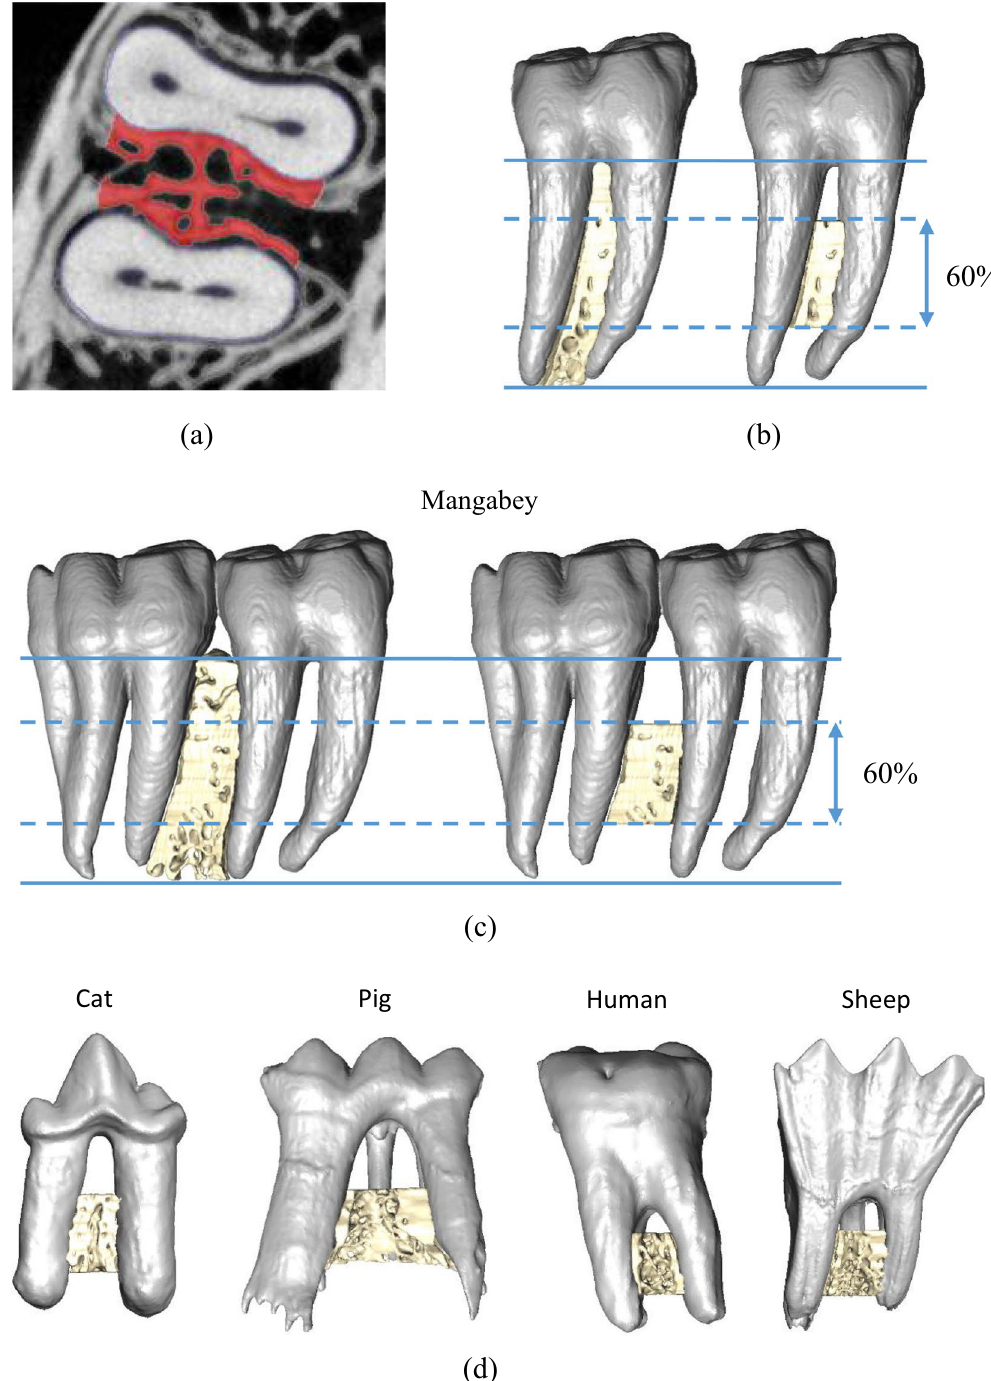
Figure 5. Segmentation of RTT and RST VOIs, showing: ( a ) mapping of the largest area of bone between the medio-lateral borders of the tooth root; ( b ) volumetric representation of the RST bone along the length of the tooth root, and creation of a VOI containing the middle 60% of the bone in the sagittal plane; ( c ) volumetric representation of the RTT bone along the length of the tooth root, and creation of the VOI in the same manner as described in ( b ); and, ( d ) the creation of RTT VOI in other